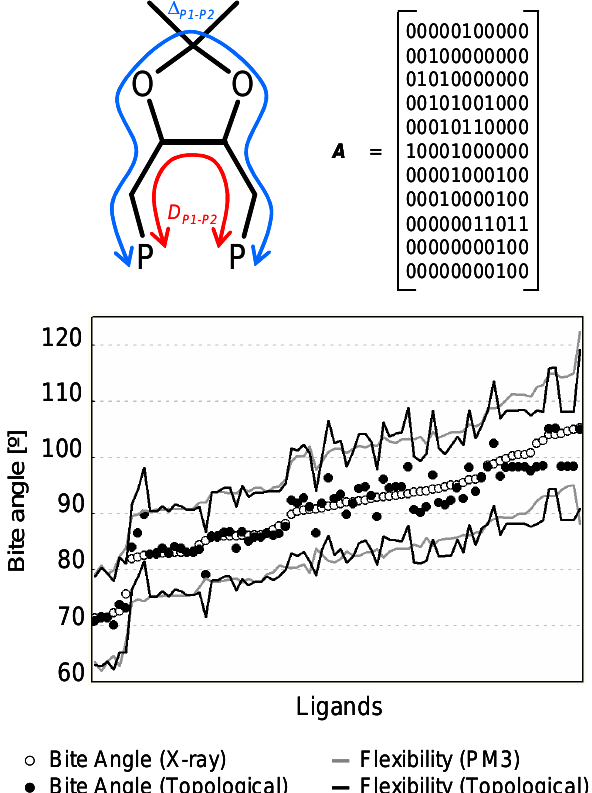
Figure 6 . (top). Molecular graph and adjacency matrix of the DIOP ligand. D and ∆ are P1-P2 P1-P2 respectively the shortest and longest P–P connectivity paths. The adjacency matrix of a molecular graph is a matrix with rows and columns labeled by graph vertices v (i.e. the atoms), with a 1 or 0 in , v ) according to whether v or v are adjacent or not. (bottom) Observed and predicted bite position ( v i j i j angle and flexibility values for a set of biphosphine and biphosphite ligands. The empty dots and the grey line represent respectively the bite angle and flexibility values calculated on a set of 80 ligand- metal complexes retrieved from the CSD. Black dots and the black line represent the same values predicted using a 2D-descriptor QSAR